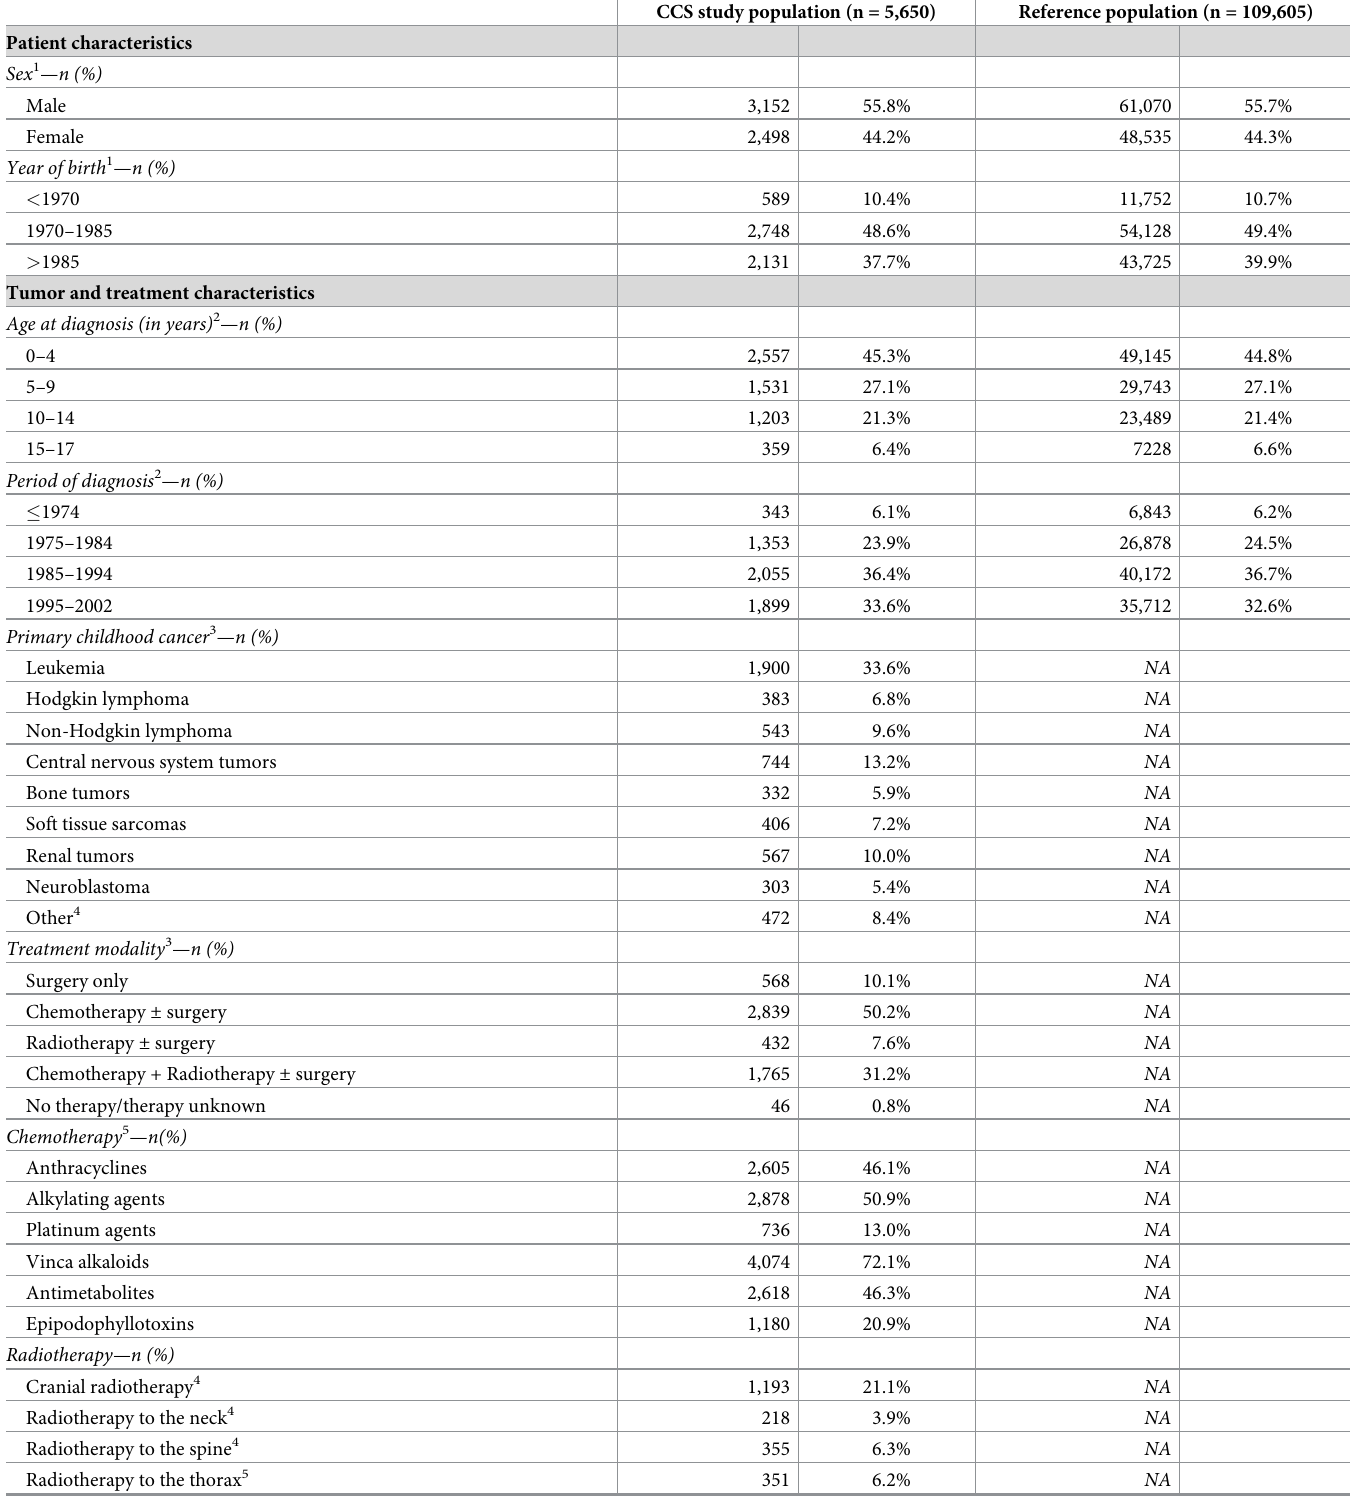
Table 1. Patient, cancer and treatment characteristics of study population of five-year childhood cancer survivors and age and sex matched reference